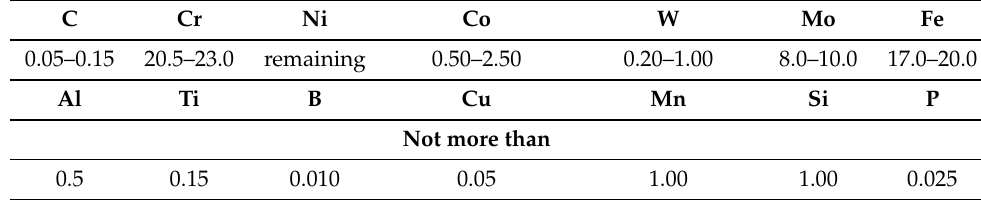
Figure 1. Diagram of meshing. Table 1. Chemical Composition of GH3536.